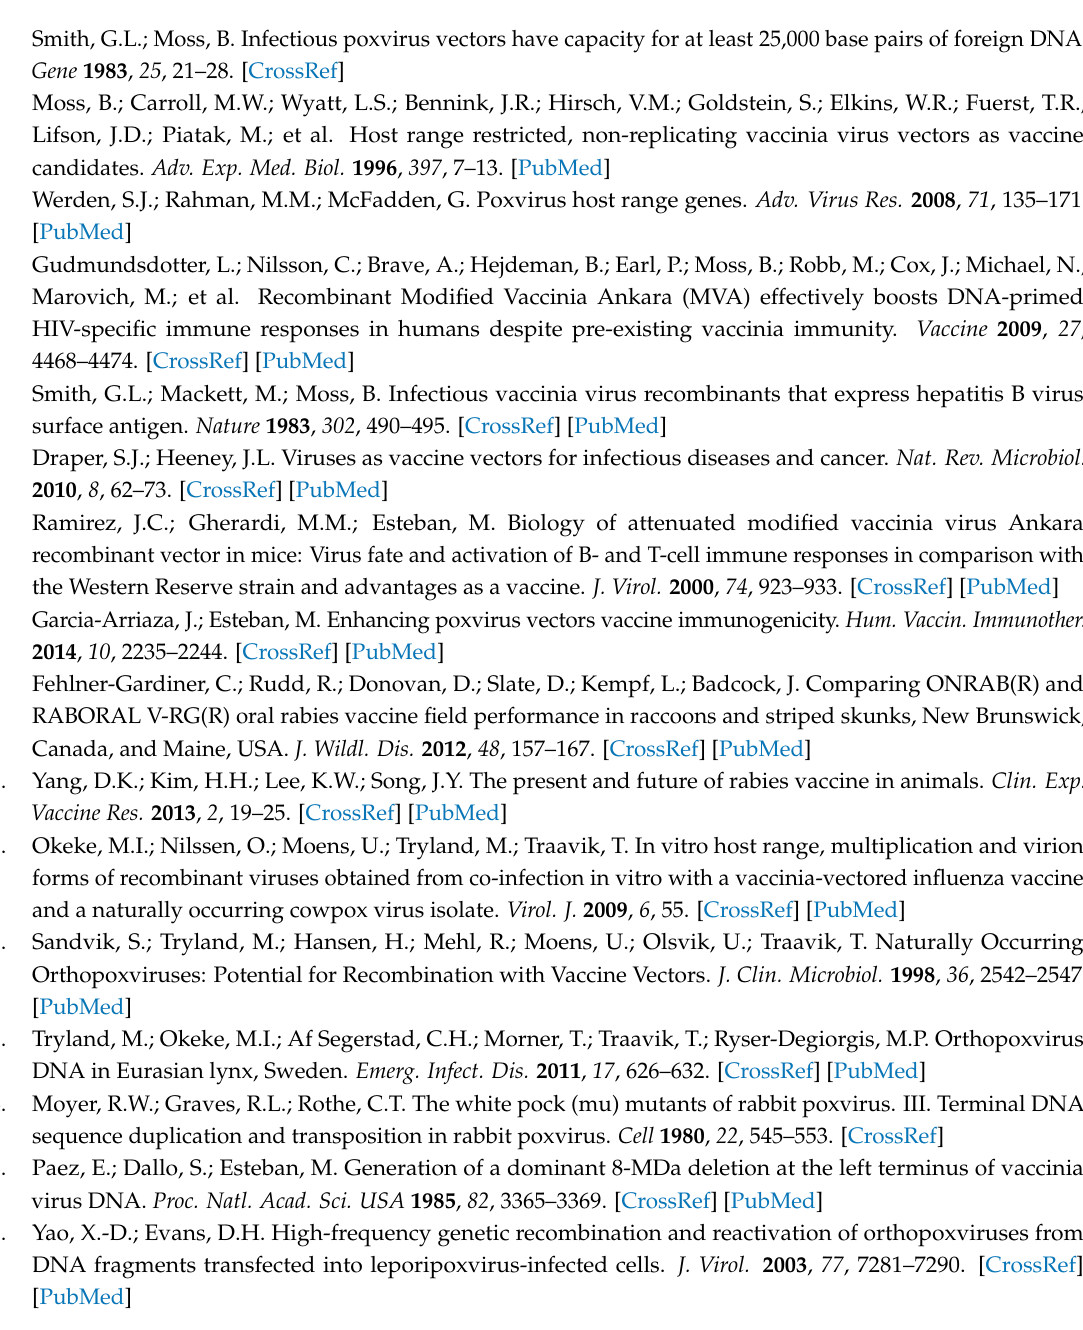
Table S1: Examples of clinically tried orthopoxvirus-derived recombinant vaccines/vectors. Acknowledgments: The supports of GenØk—Centre for Biosafety, Tromsø, Norway; and Uit—The Arctic University of Norway, Tromsø are